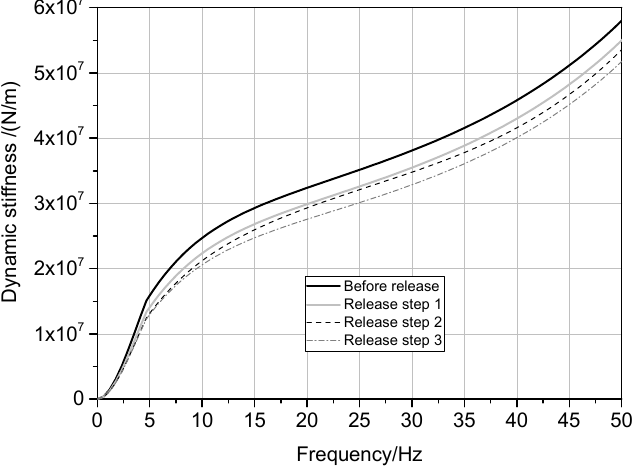
0.4 m, and 0.1 m for model P3 ( H = 1.0 m) were computed.